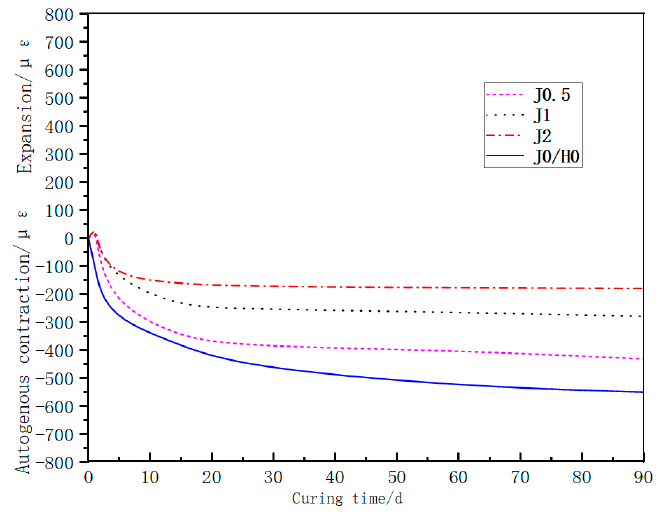
Figure 6. Effect of shrinkage-reducing agent on the autogenous shrinkage of concrete.